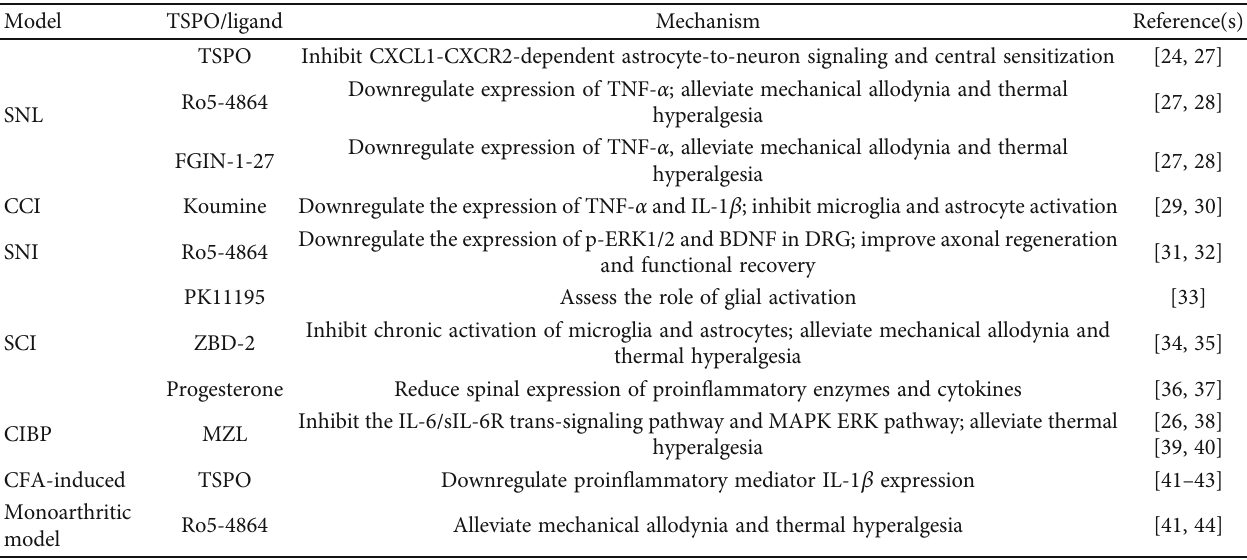
Table 1: Role of TSPO and its ligands in chronic pain.